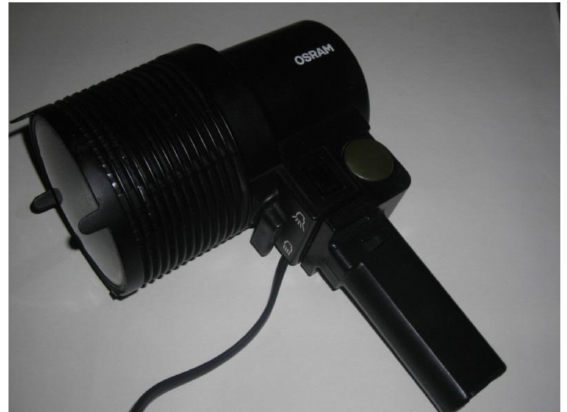
Figure 5. Adopted lamp: Osram SLV1000 (by courtesy of [67]).